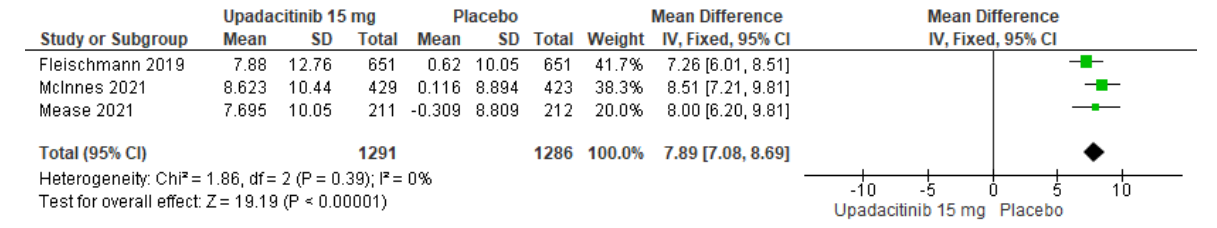
Figure 2. Forest plot of the comparison: upadacitinib vs. placebo. Outcome: high-density lipoprotein cholesterol (mg/dL) [17,20,22].